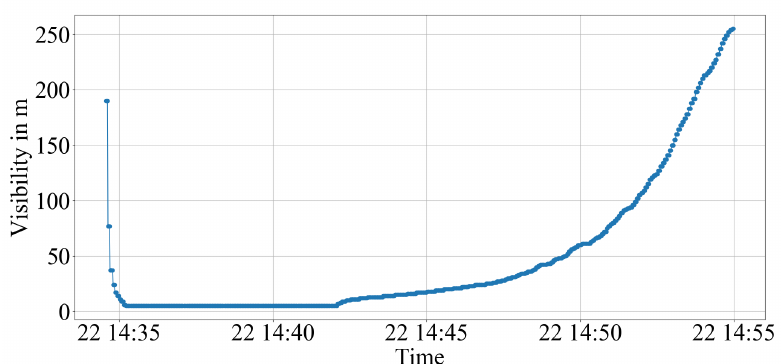
Figure 8. Visibility measured by the transmissiometer during fog